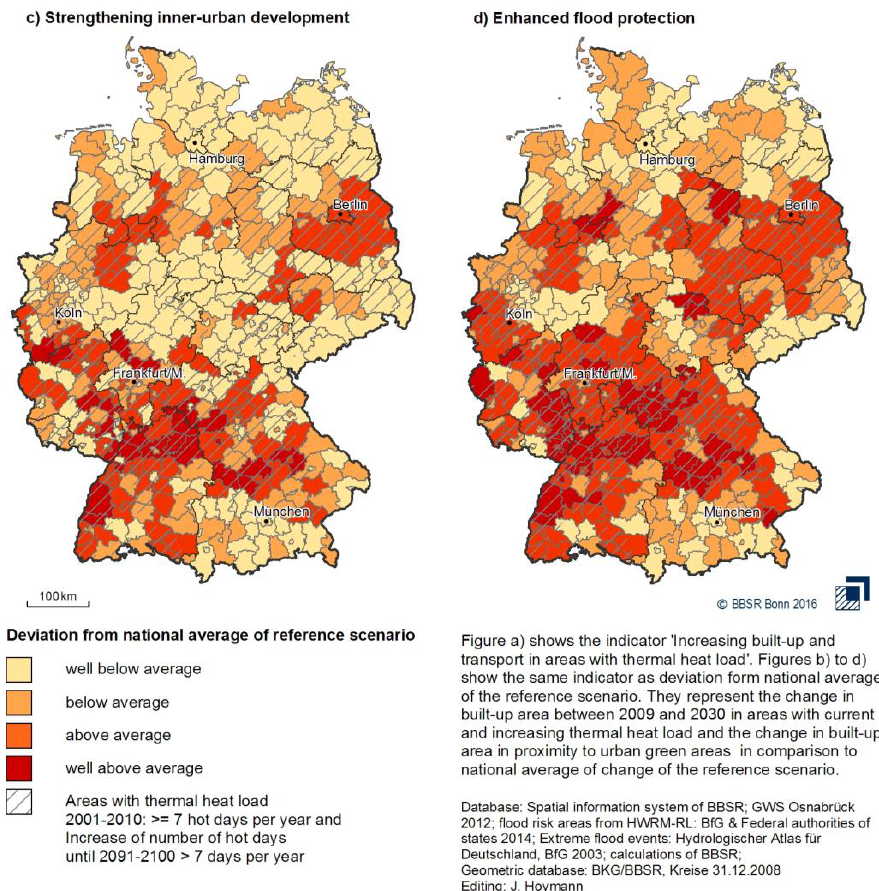
Figure 5. Land consumption in areas with heat stress. Comparing the ( a ) reference and alternative scenarios with: ( b ) “Preserving and developing urban green areas”; ( c ) “Strengthening inner-urban development”; and ( d ) “Enhanced flood protection”.